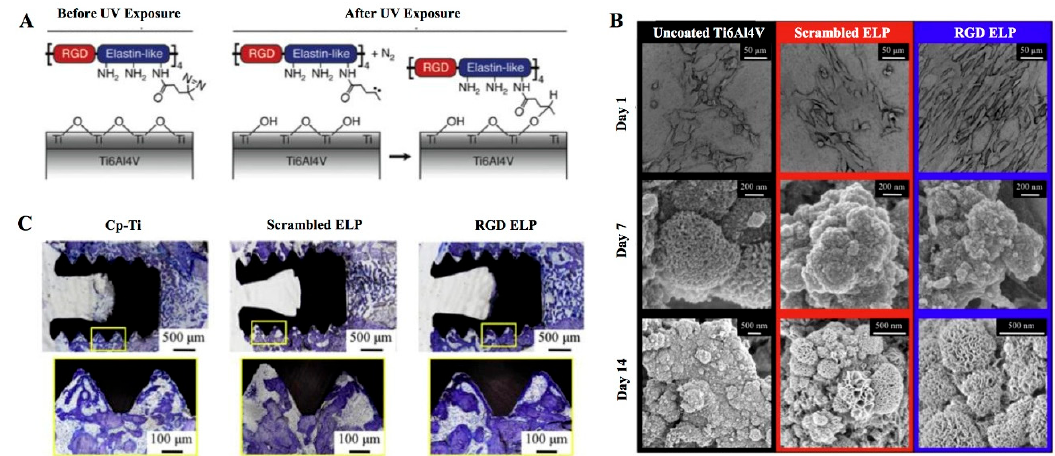
Figure 6. Engineered elastin-like protein (ELP) improve the osseointegration of implants. ( A ) Schematic of proposed ELP conjugation to titanium substrates upon exposure to UV light; ( B ) MG63 and mineralization morphology on uncoated, scrambled ELP, and RGD ELP spin coated Ti-6Al-4V. SEM images were taken at 1, 7, and 14 days post-seeding of MG63s in mineralization medium; ( C ) Histological sections of inserted screws at 1 week [110]. Copyright 2016 Elsevier Ltd.